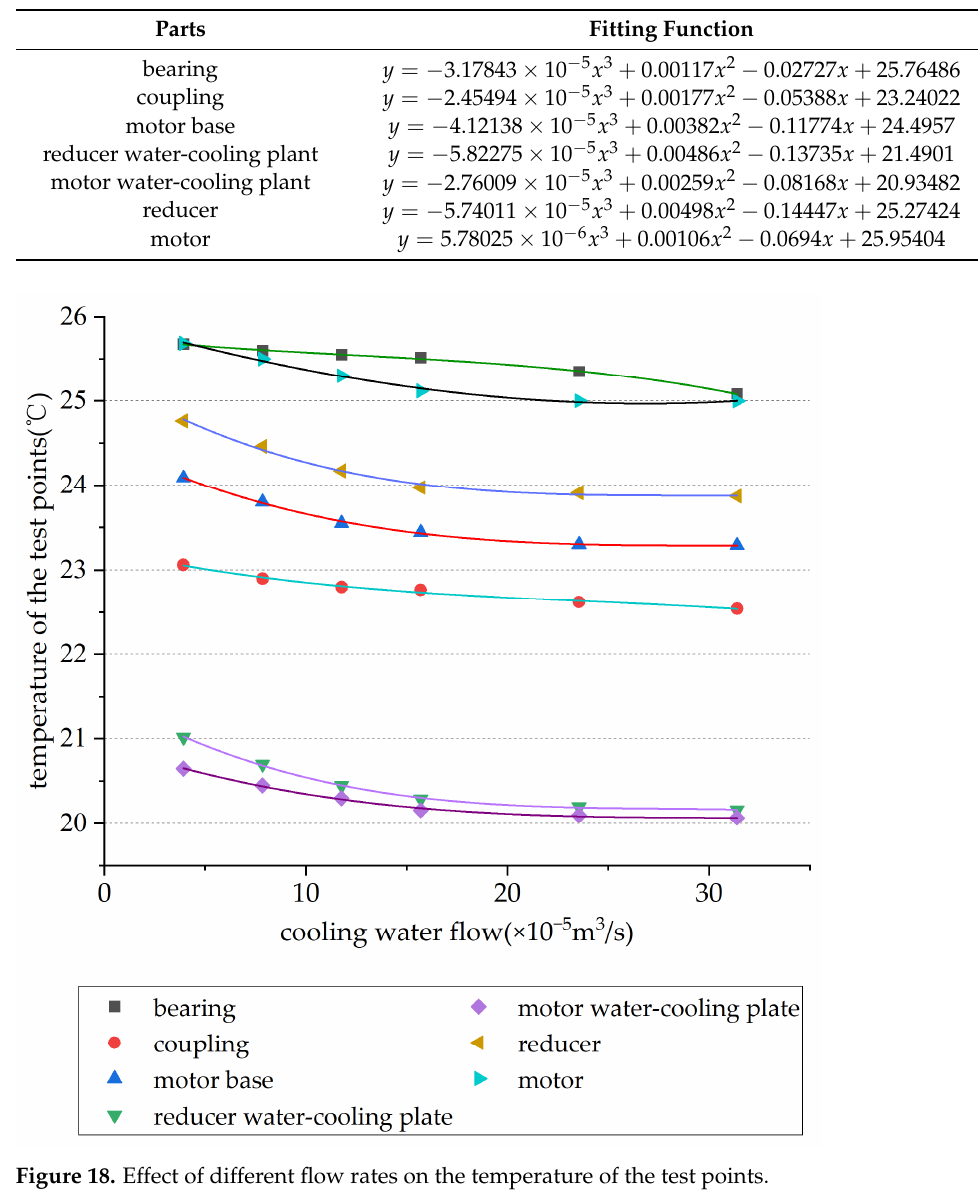
Figure 18. Effect of different flow rates on the temperature of the test points.